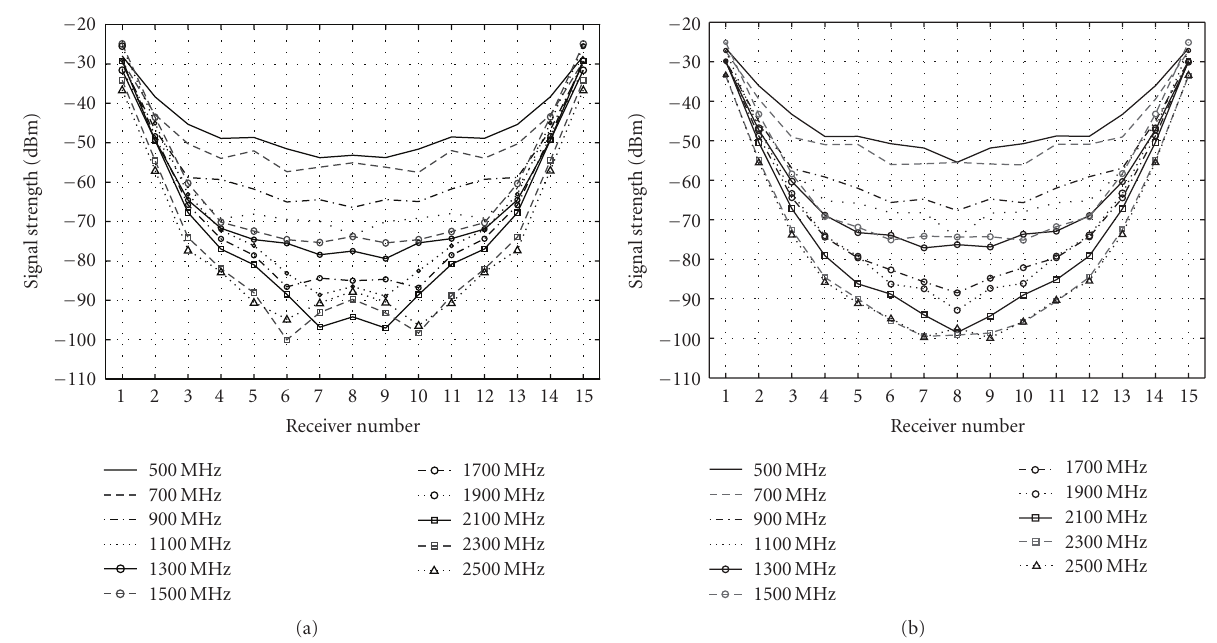
Figure 10: Plots of the transmitted signal strength as a function of receiver number over the frequency range of 500–2500 MHz for the 3.4 cm length antennas with their centers submerged (a) 2.0 cm and (b) 6.5cm below the 90% glycerin coupling liquid surface,